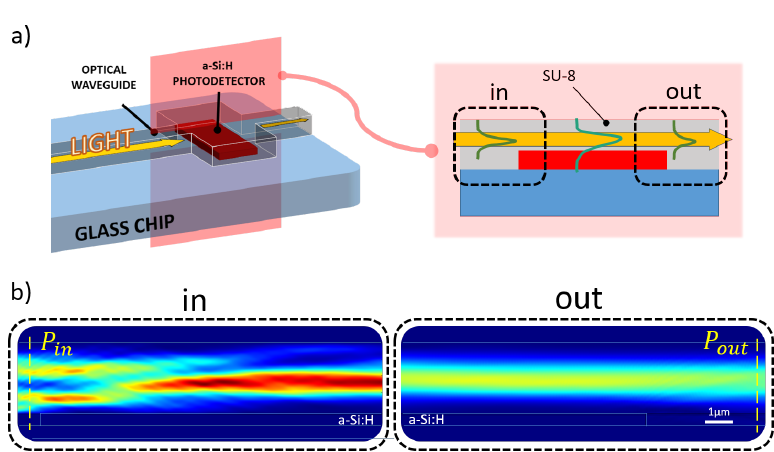
Figure 2. Simulated optical coupling scenario. ( a ) Longitudinal section of the coupling site numer- ically analyzed to evaluate the amount of optical power absorbed by the diode (a-Si:H) from the overlapped SU-8 waveguide. ( b ) Optical power distribution along the propagation direction (from left to right) light entering (“in” box) and leaving (“out” box) the overlapping site.